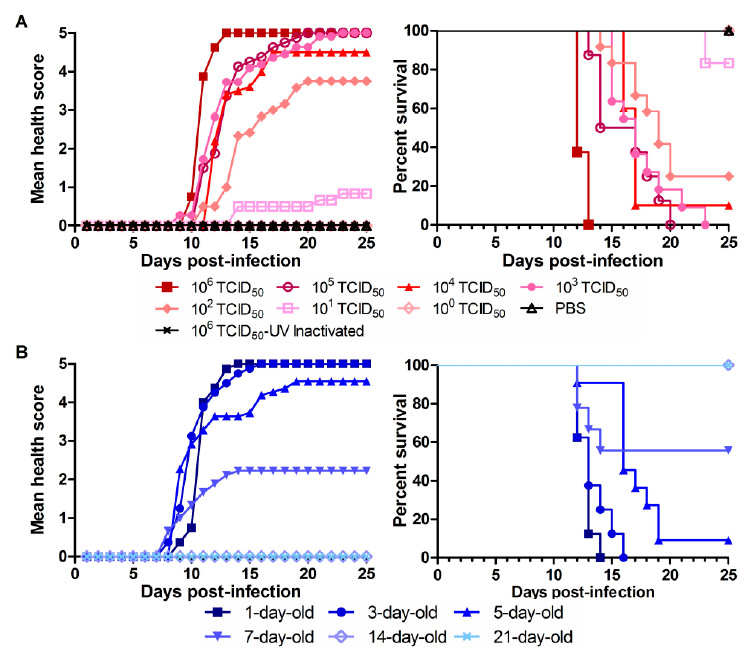
Figure 3. Viral dose-dependent lethality and animal age-dependent lethality by PRVABC59 in neonatal mice. ( A ) A serial 10-fold dilution was made for PRVABC59 stock. One-day-old mice were injected i.p. with PRVABC59 of 10 6 –10 0 TCID 50 /mouse, or with the UV-inactivated virus of 10 6 TCID 50 or PBS; ( B ) Different days old mice (C57BL/6) were infected i.p. with 100 μ L PRVABC59 (10 6 TCID 50 /mouse). All the mice were observed for 25 days after infection or until death. Each group contains 8–10 mice.